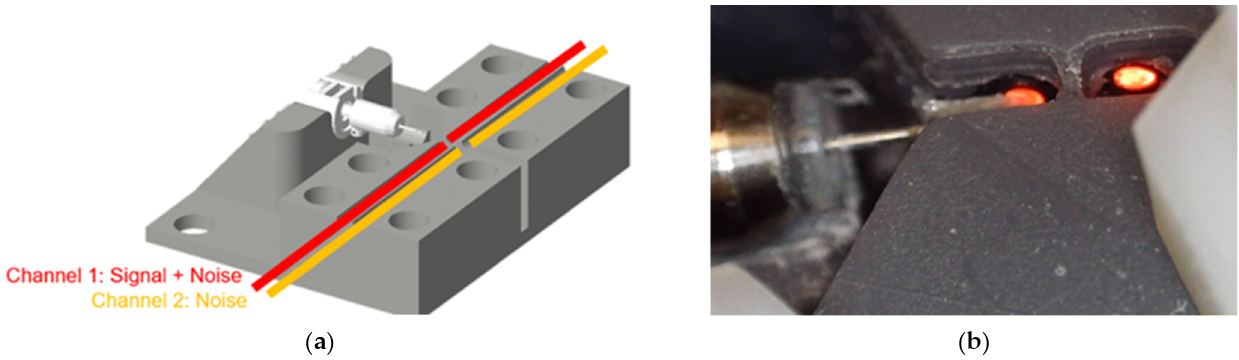
Figure 5. ( a ) Visualization of the 3D-printed test setup, showing the Carina middle ear actuator (white) and the two fiber pairs (red and orange) mounted in the setup (gray). ( b ) Close-up of the actuator positioned directly before the light beam